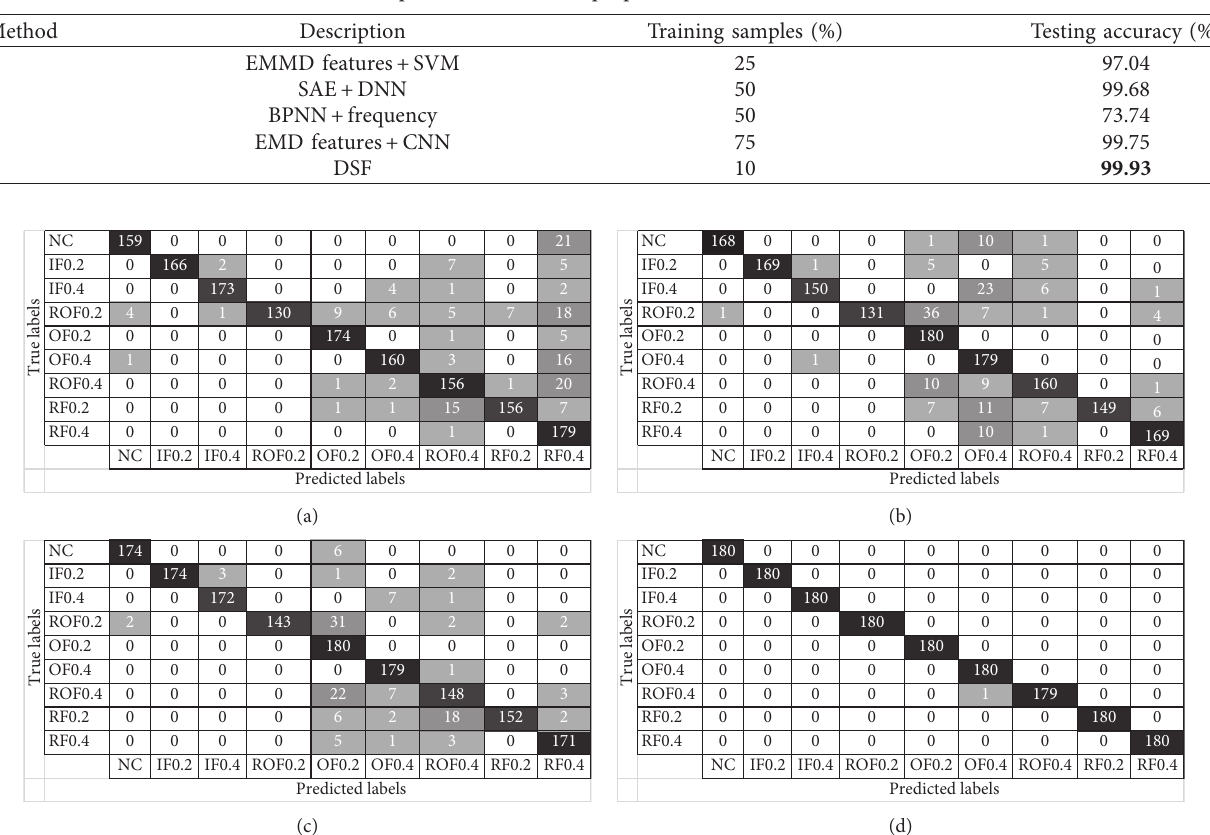
Table 1: Performance comparison between the proposed DSF method and some classical method.